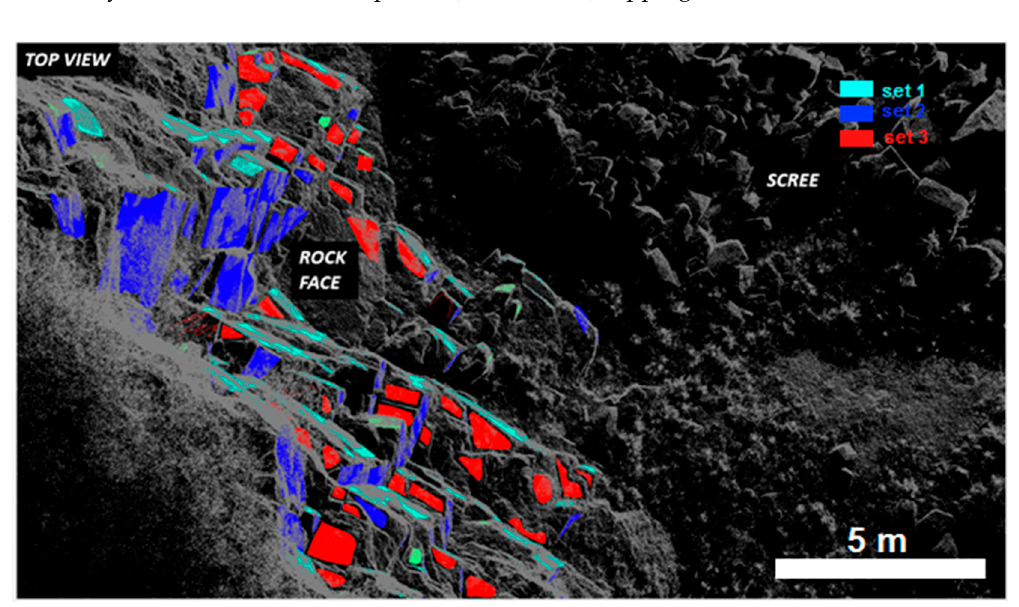
Figure 7. Top view of the rock wall. The coloured facets highlight the discontinuity network identified in Figure 8. The blue and teal patches identify joint Sets 1 and 2, responsible for isolating columnar-like prisms and acting as release planes. The red patches identify the joint Set 3, acting as a basal plane. Set 4, in green, is rarely mapped because of its geometrical orientation (near horizontal). Scale bar is indicative.